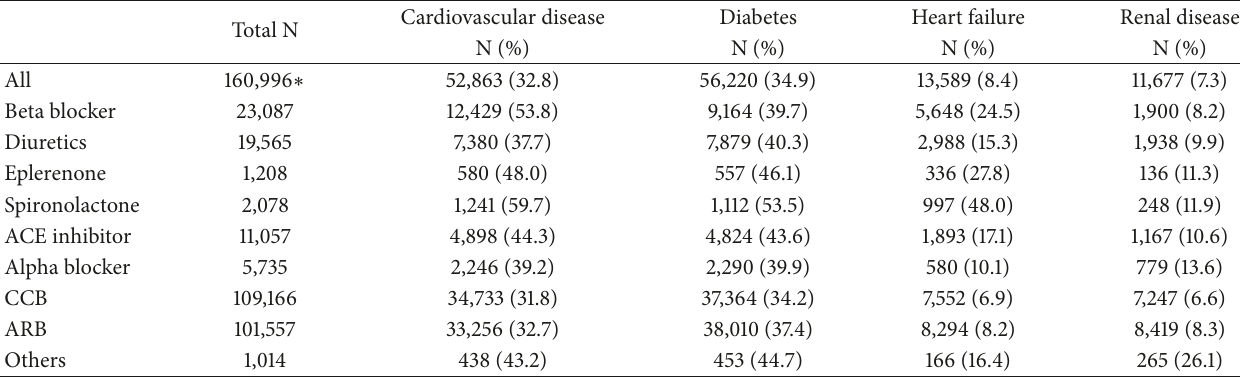
Table 2: Concomitant antihypertensives received for concomitant diseases: patients on all antihypertensive drugs during the last claim month of stable treatment ( ≥ six months of treatment with the same drugs). Cardiovascular disease Total N